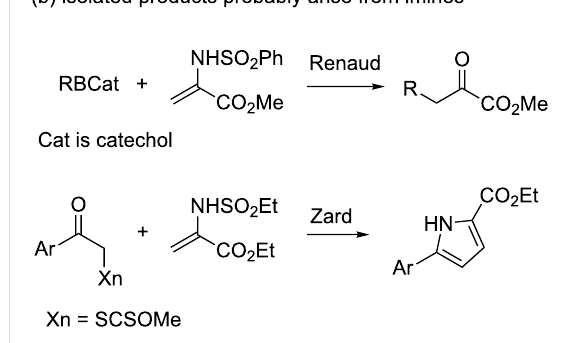
Figure 1: (a) Radical reactions of ene-sulfonamides give diverse isolated products; (b) these products are often derived from transient imine intermediates.